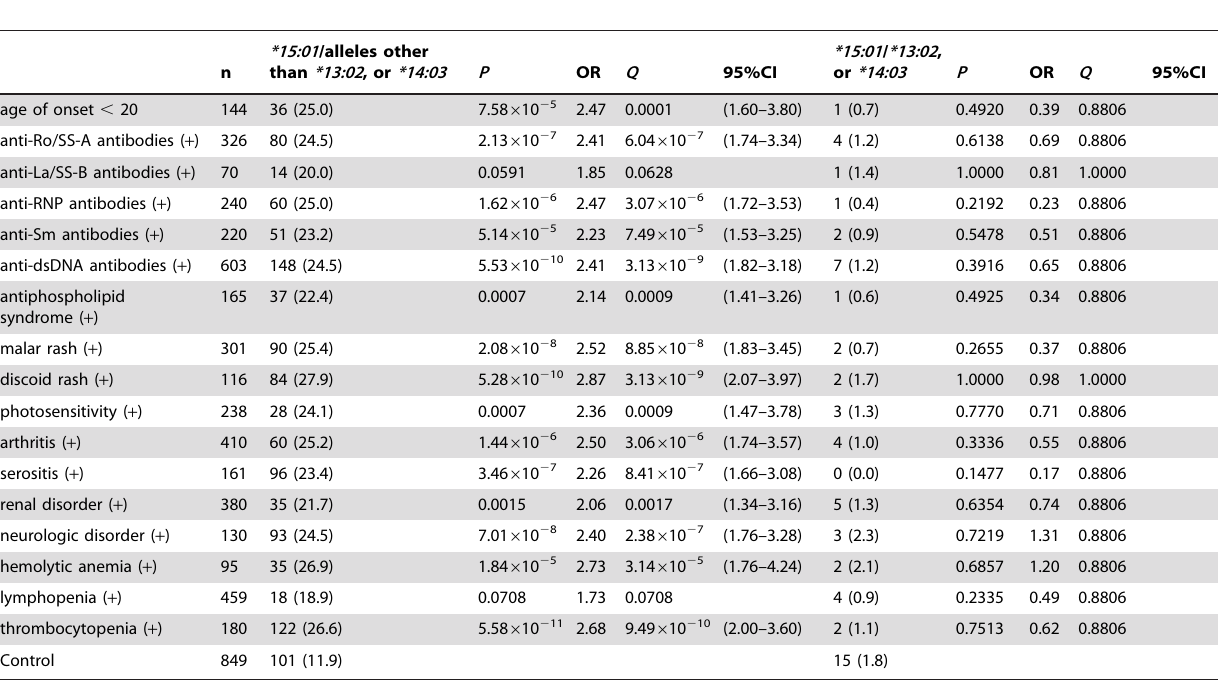
Table 3. HLA-DRB1 genotype frequency in the SLE patients and controls relative to SLE